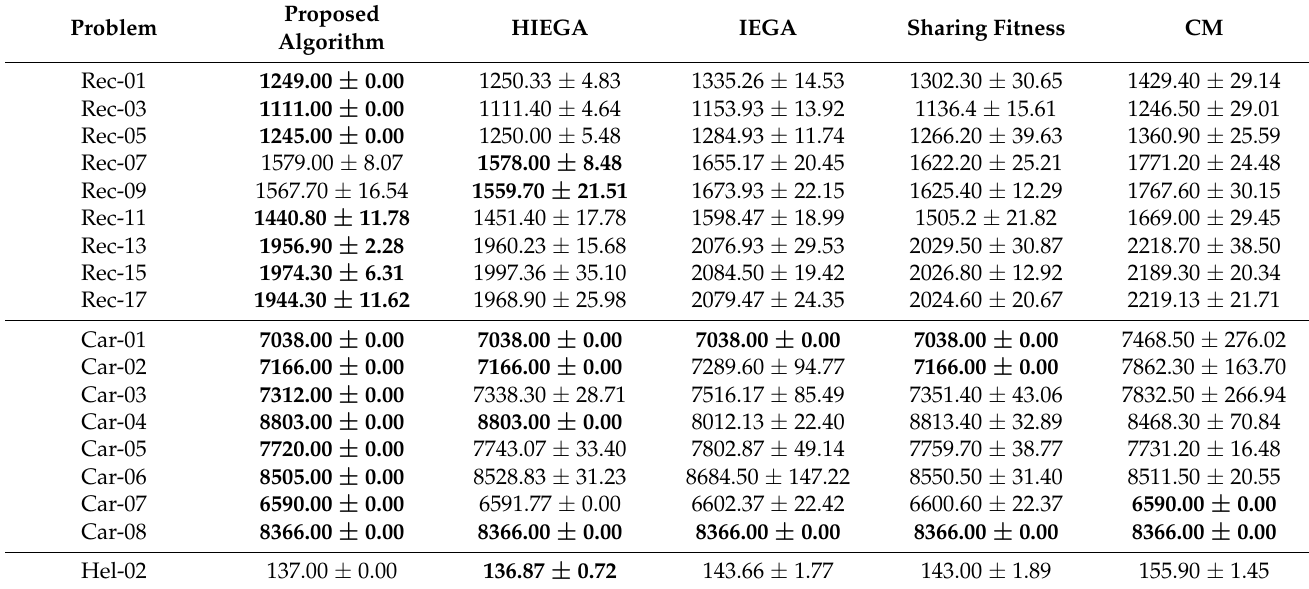
Table 3. Mean value and standard deviation of the optimal solution found after 10 independent simulations using the